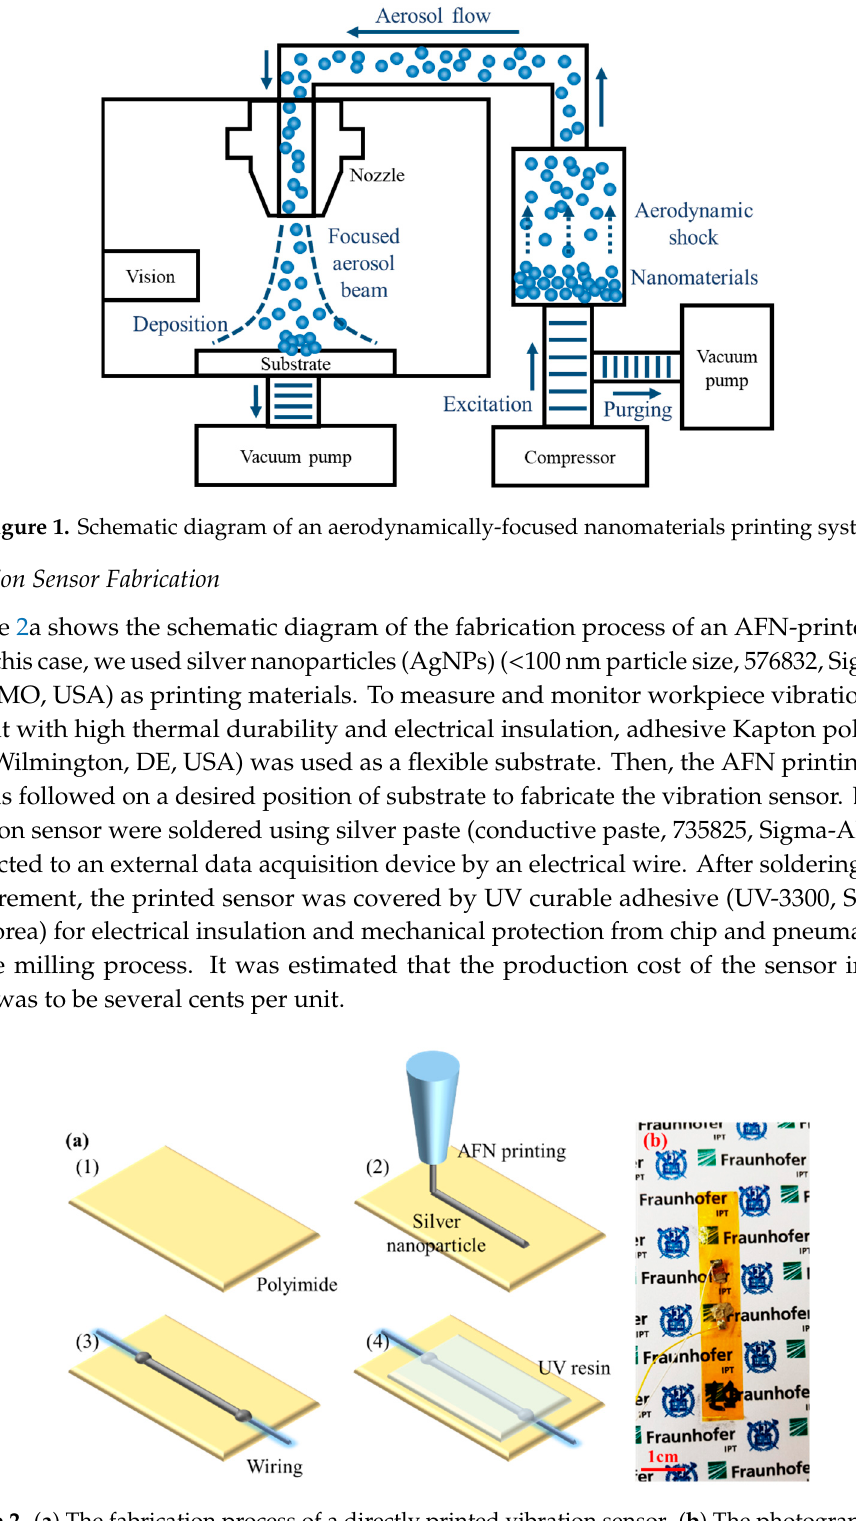
Figure 2. ( a ) The fabrication process of a directly printed vibration sensor. ( b ) The photograph of the fabricated vibration sensor.